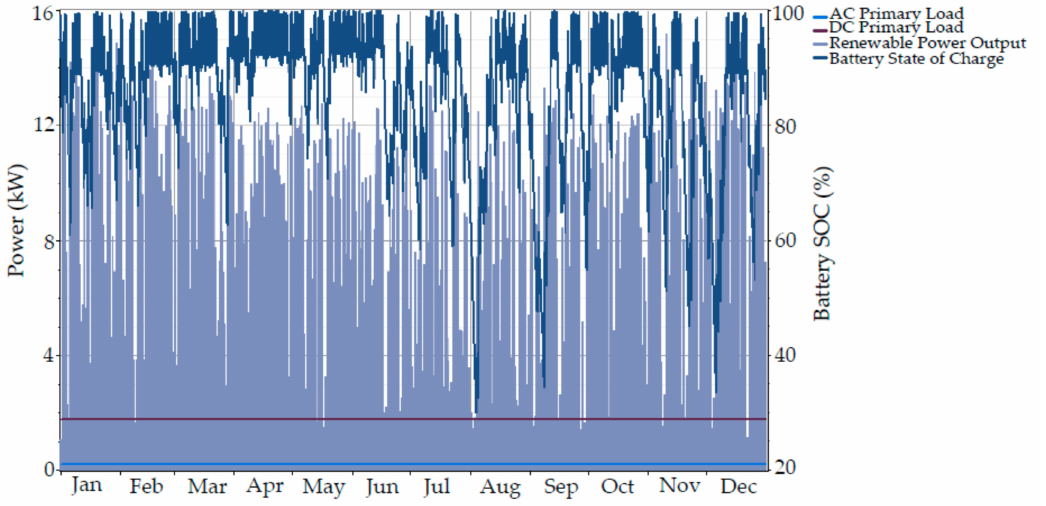
Figure 16. The average hourly power contribution of the PV array and battery bank.